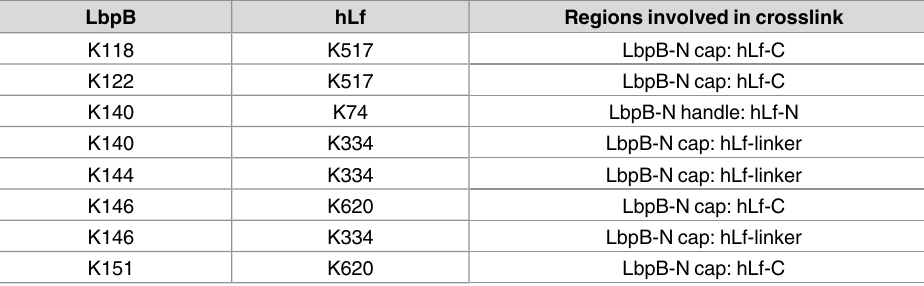
Table 1. Crosslinked lysines in the hLf:LbpB